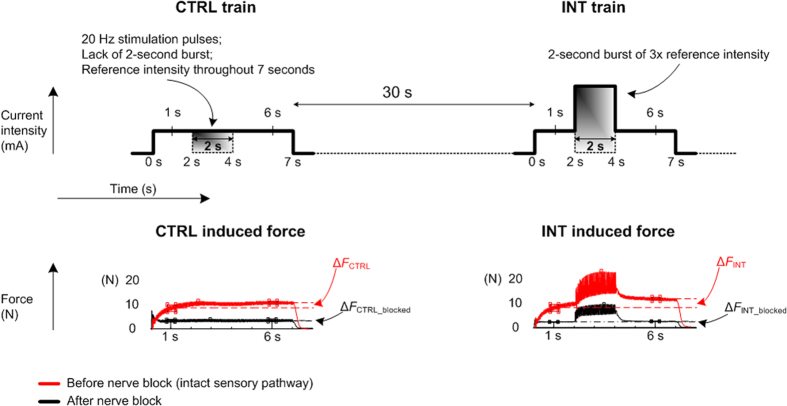
The electrical stimulation applied in this study include CTRL (control stimulation of reference intensity) and INT (intensity-modulated stimulation that includes a burst of increased intensity between 2 s and 4 s) trains that last 7 seconds.The profile of CTRL and INT induced force before and after nerve block demonstrates corticospinal contribution (ΔFCTRL > ΔFCTRL_blocked and ΔFINT > ΔFINT_blocked) while the presence of increased intensity between 2 s and 4 s in unblocked/intact conditions demonstrates different levels of corticospinal contribution (ΔFINT > ΔFCTRL).